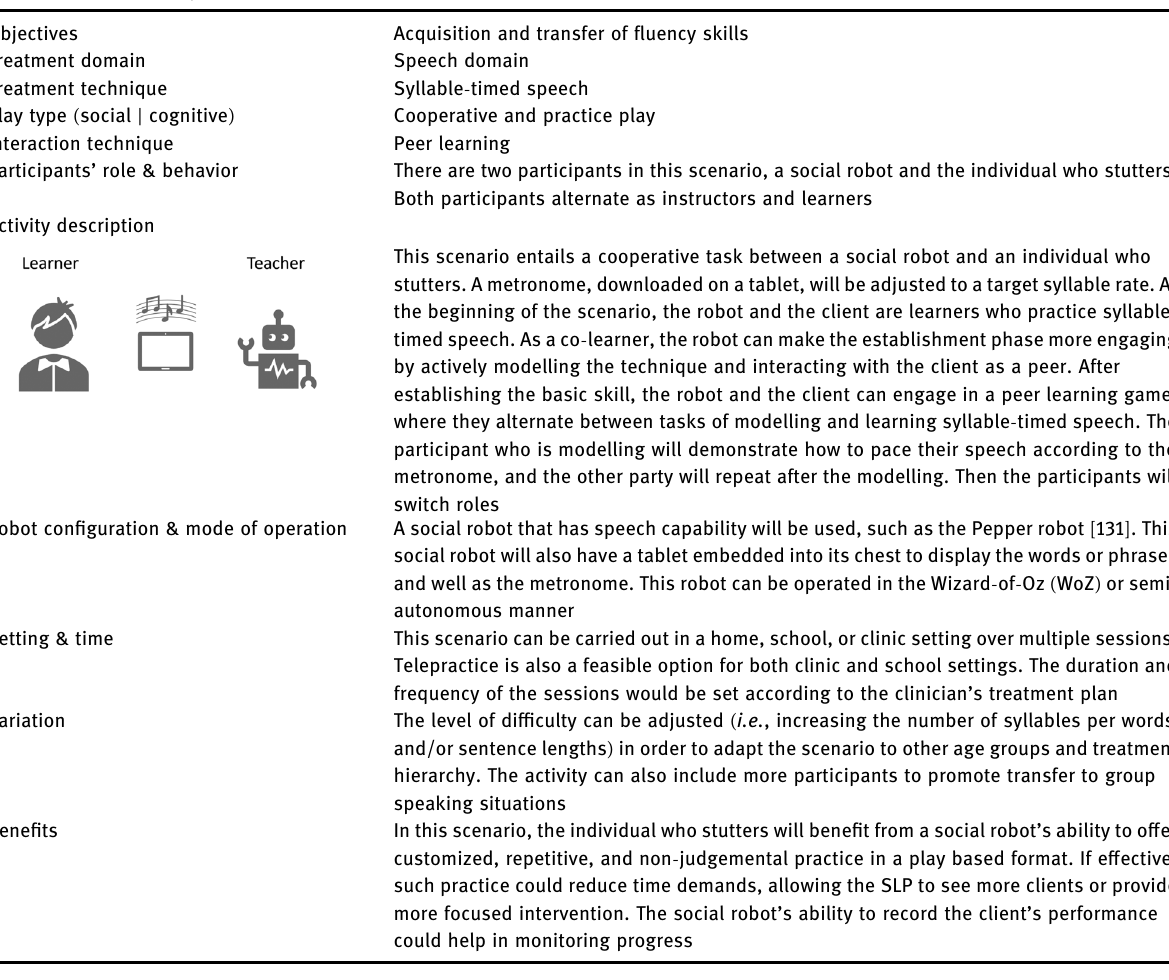
Table 1: Description of scenario 1 Scenario 1: Beats with peers